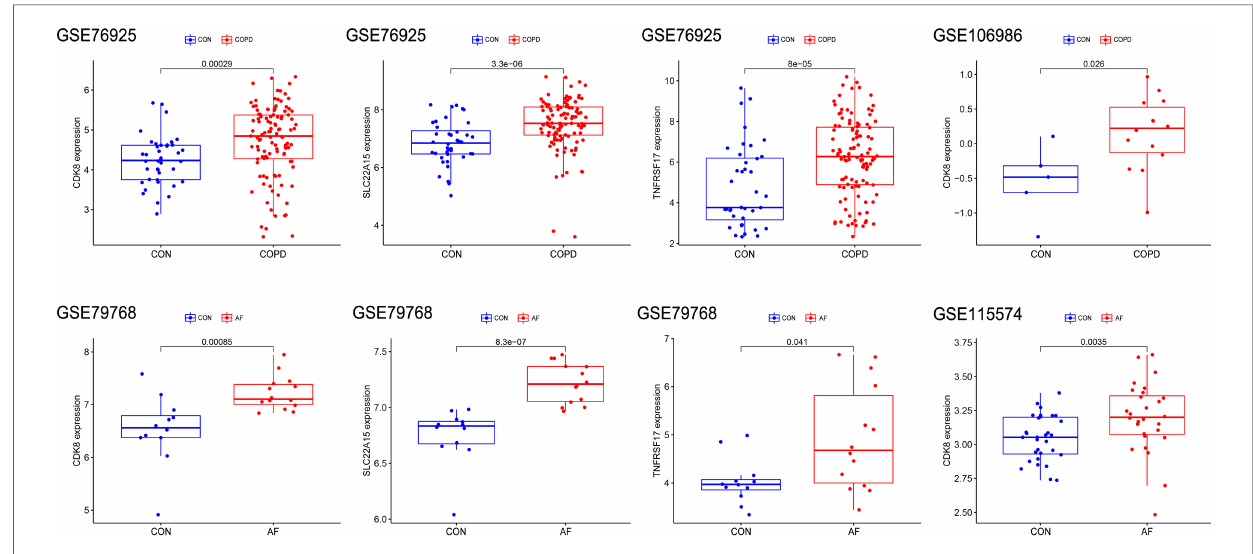
FIGURE 5 Validation of Hub gene expression levels in training and validation sets. The red box represents the disease group, and the blue represents the control